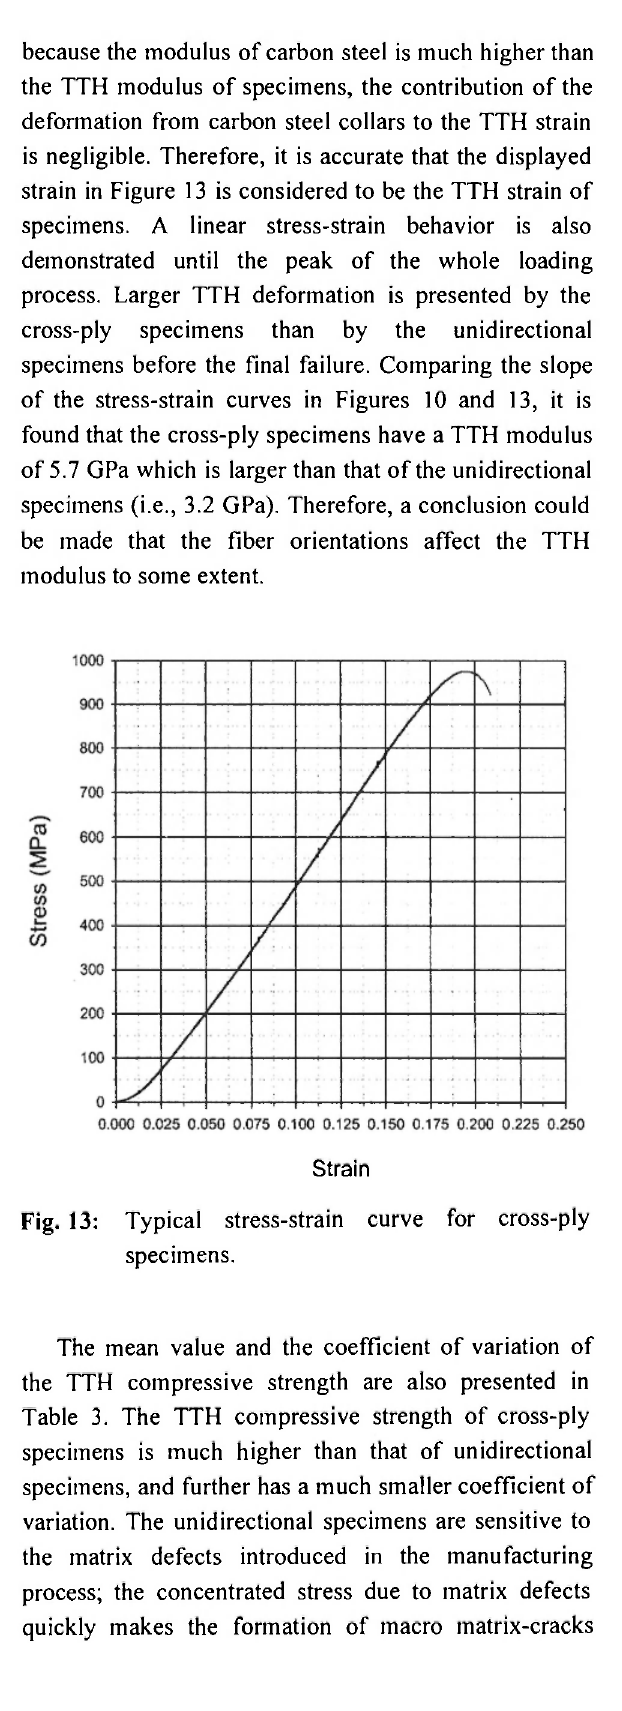
Fig. 13: Typical stress-strain curve for cross-ply